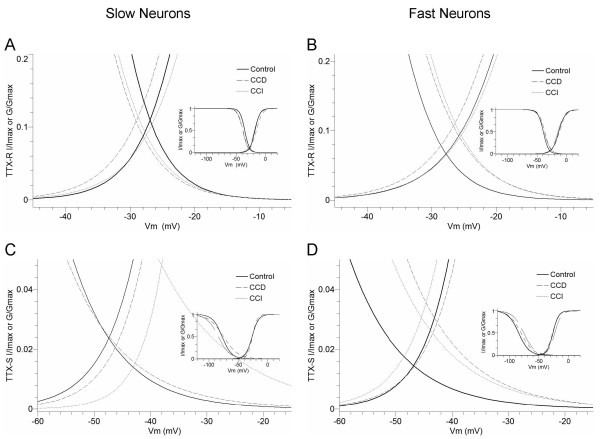
Alteration of the window current of activation and steady-state inactivation curves in the slow and fast small DRG neurons after CCD and CCI treatment. Boltzmann fits from the data shown in Fig. 4 and 5 are shown in A-D. The small figures inserted in each figure illustrate the overview of the activation and inactivation fit curves.